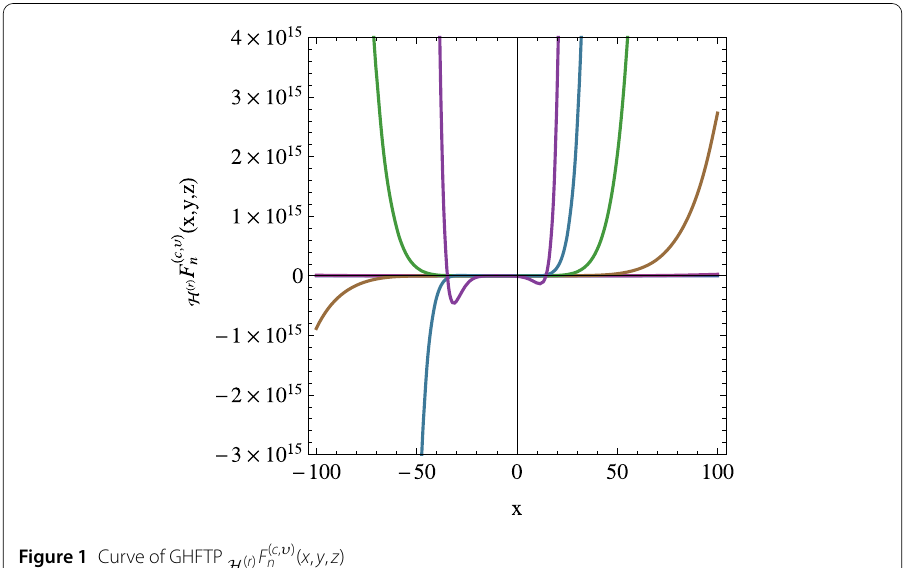
Figure 1 Curve of GHFTP H ( r ) F ( c , υ ) n ( x , y , z